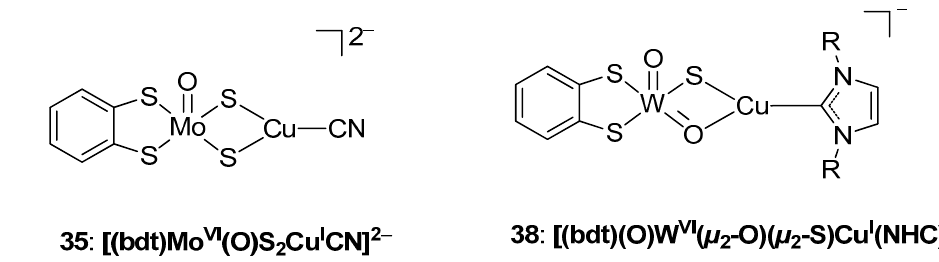
Figure 8. Two model complexes of [MoCu]CODHs.